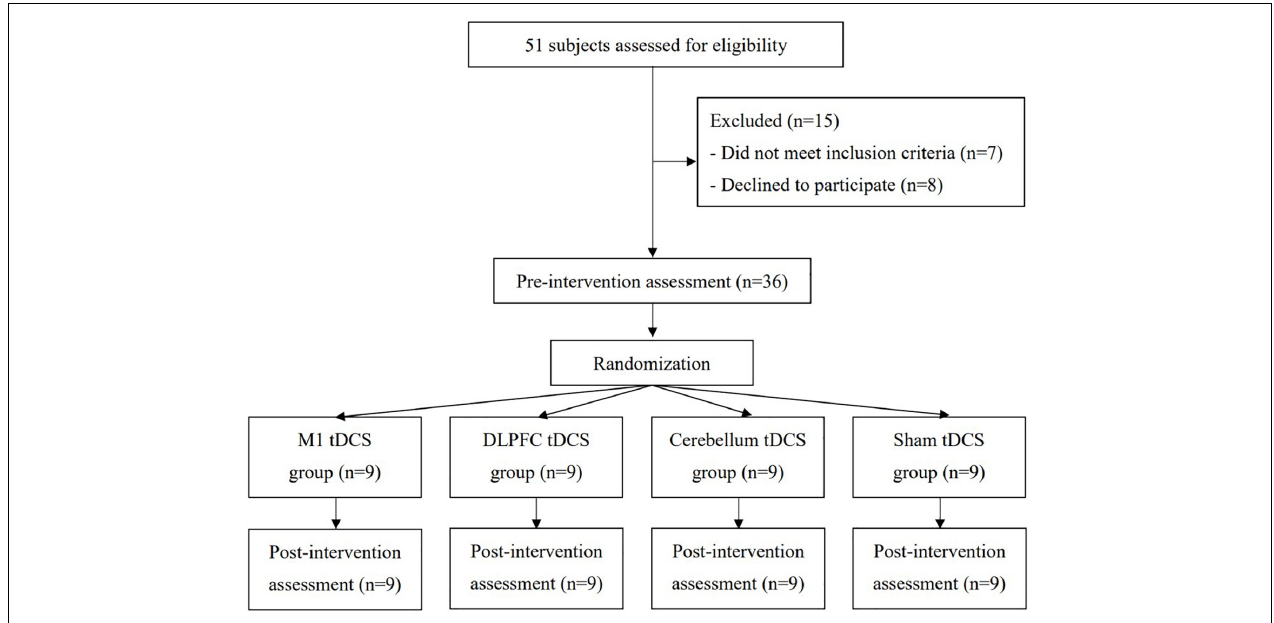
FIGURE 1 | Flowchart of the patient inclusion and study